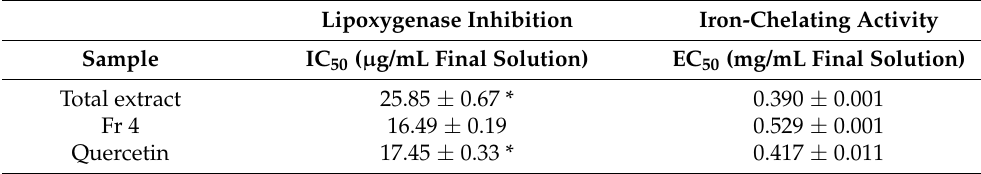
Table 3. Antioxidant activity of T. erecta total extract and fraction 4 (Fr